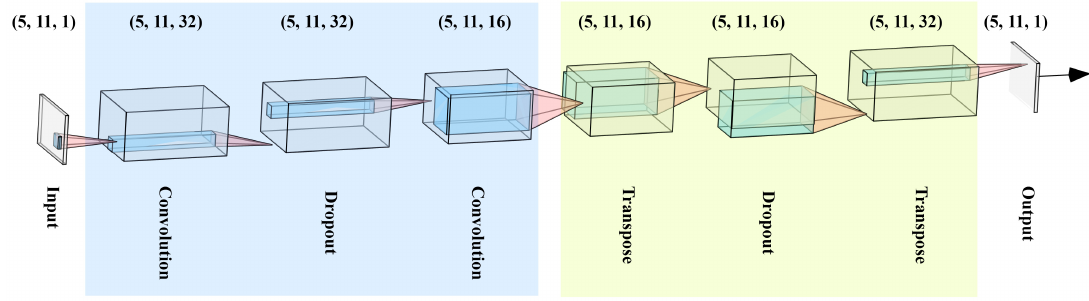
Figure 3. Architecture of the proposed method. Convolutional layers in AE are used to capture information in signal sequences. This architecture tries to replicate the input signal at its output based on the learned data